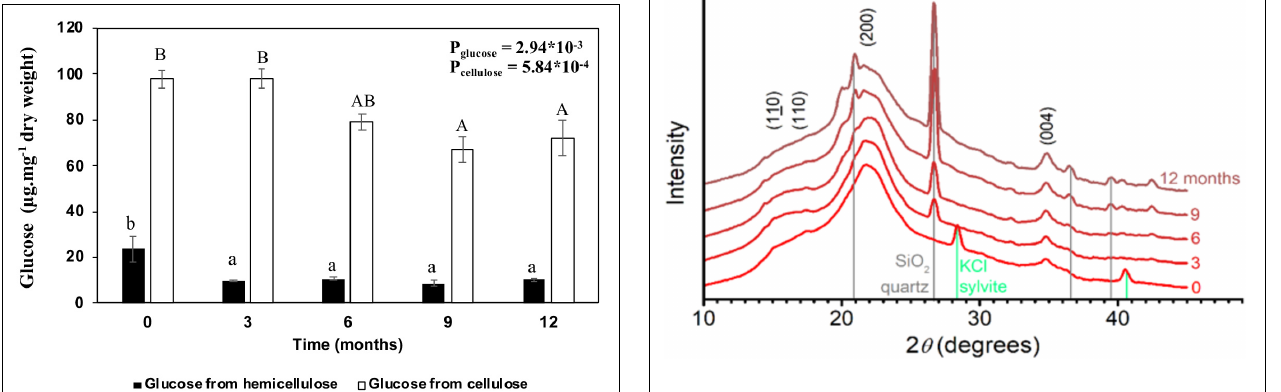
quartz (SiO 2 ) became progressively more prominent ( Figure 6